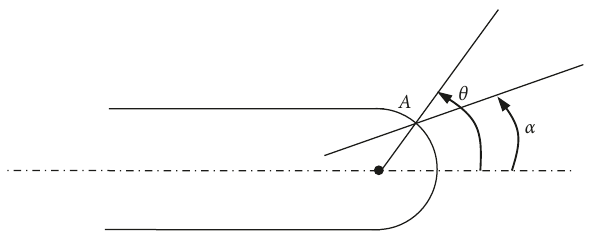
Figure 7: The schematic diagram of the relationship between θ and α